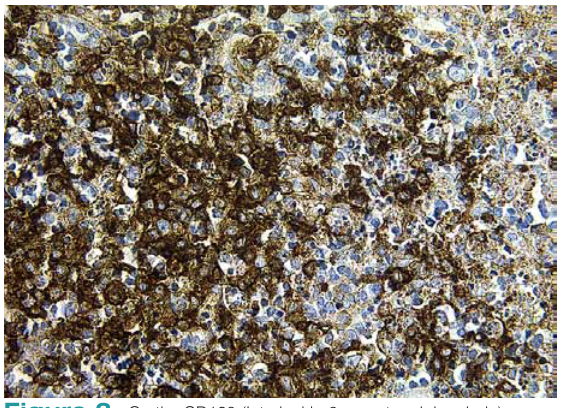
Figure 3. On the CD123 (Interleukin-3 receptor alpha chain) immunostain, numerous CD123-positive plasmocitoid monocytes are noted in the necrotic lesion. CD15, CD30, EBV and ALK-1 immunostain were negative as well as PAS and Ziehl-Neelsen